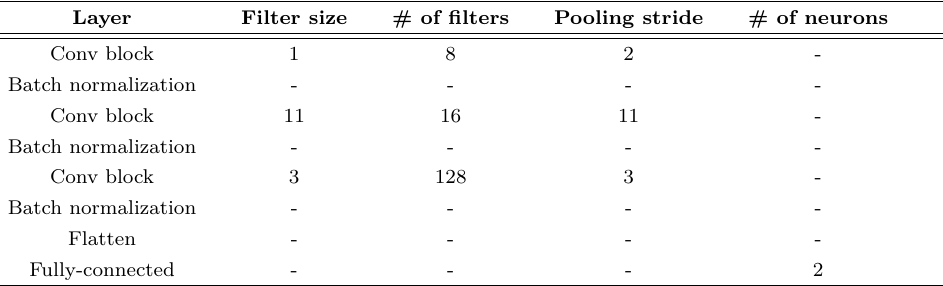
Table 5: CNN architecture of the SAKURA_AES dataset.